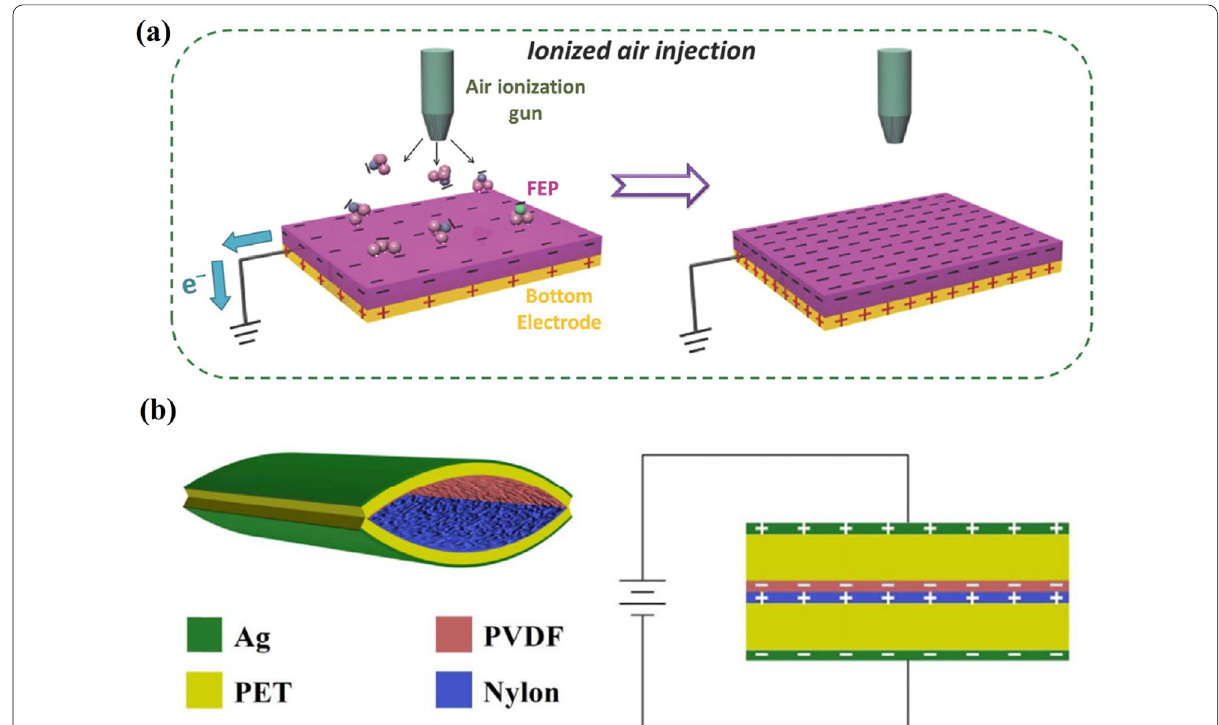
Fig. 14 Charge injection techniques: a a process of the ion injection on the FEP film (Reproduced with permission from Ref. [89]); b a structure of the high-performance TENG and schematic image of the equipment used for charge injection (Reproduced with permission from Ref.